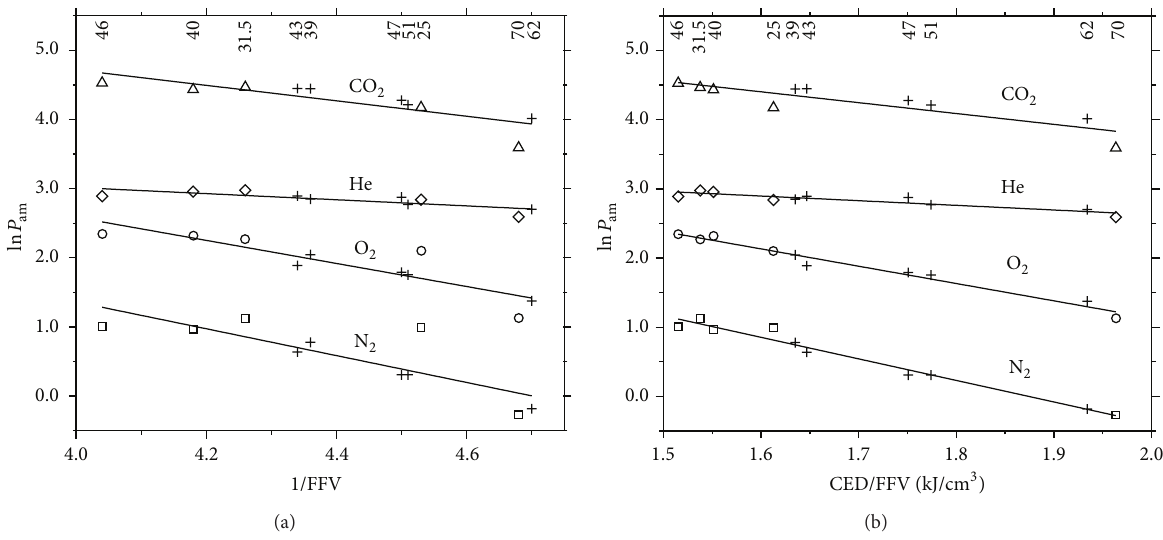
Figure 2: Correlation of permeability with (a) 1/FFV and (b) CED/FFV for the EVA based materials including both pure EVA copolymers (empty points) and their blends (+). Straight lines represent linear regressions of the experimental data. Numbers on the top axis represent vinyl acetate content. The plots for CO 2 , O 2 , and N 2 shown in (a) are based on the data taken from our previous work [17] with permission from A. Wolinska-Grabczyk, P. Kubica, A. Jankowski, and J. Membrane Sci. , 443, 227-236, Elsevier, copyright 2013.